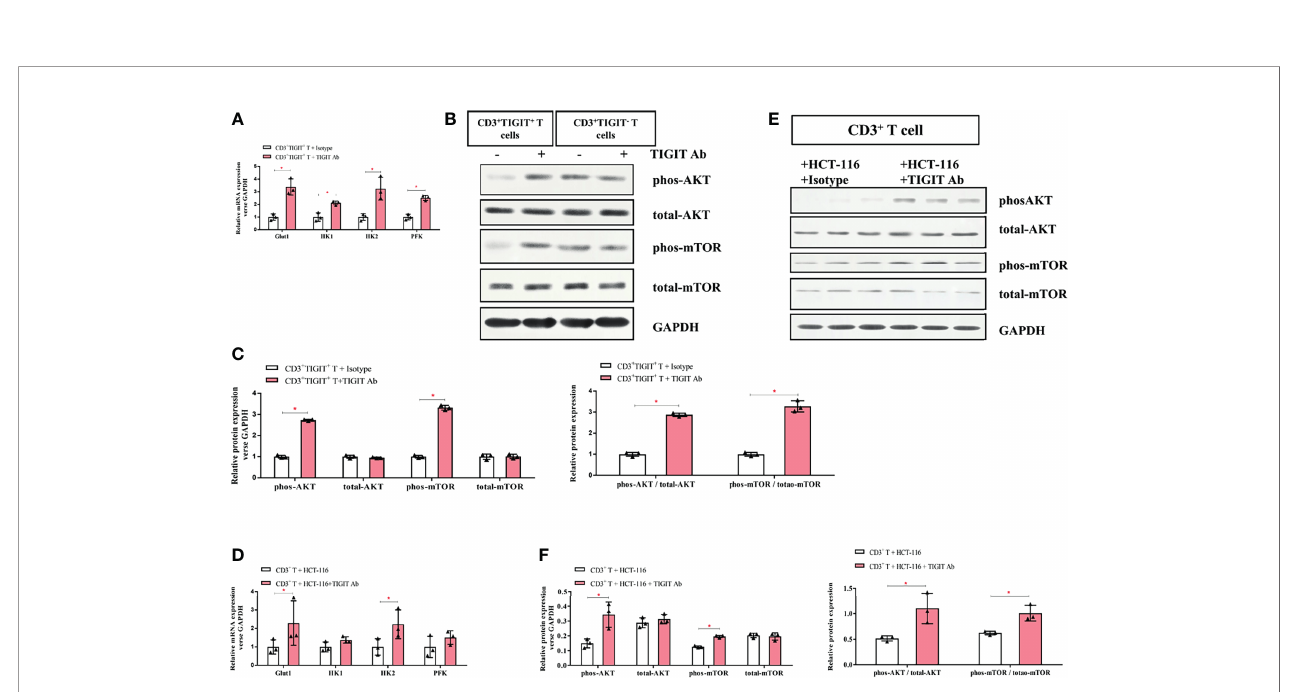
FIGURE 5 | TIGIT blockade restores the glucose metabolic activity of T cells. (A) mRNA expression of Glut1, HK1, HK2, and PFK elevated in TIGIT Ab group compared with the control group in CD3 + TIGIT + T cells. (B) Representative western blots for the control group and TIGIT Ab group in CD3 + TIGIT + T cells and in CD3 + TIGIT - T cells. (C) Western blotting analysis of the phosphorylation levels of the AKT/mTOR pathway in the control group and TIGIT Ab group in CD3 + TIGIT + T cells. Then, CD3 + T cells stimulated with aCD3/CD28 were co-cultured with HCT-116 at a ratio of 5:1. In the co-culture system, isotype control and TIGIT Ab were respectively added as the control group and experimental group. (D) mRNA expression of Glut1 and HK2 elevated in the experimental group . (E) Representative blots of the control group and the experimental group were shown. (F) Western blotting analysis of the phosphorylation levels of the AKT/mTOR pathway in the control group and the experimental group. * P <